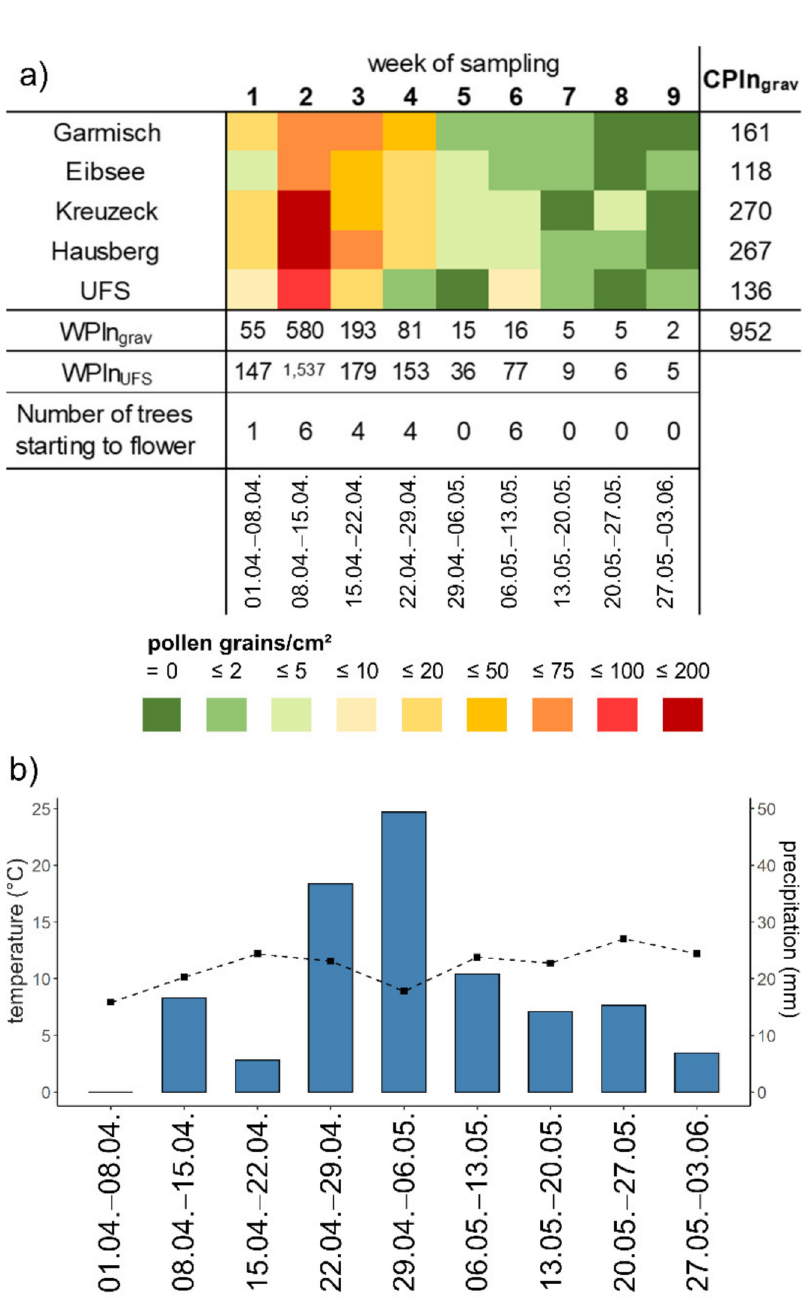
Figure 5. ( a ) Heat map showing weekly birch pollen deposition (pollen grains/cm 2 ) on the horizontal slides during the flowering period 2020, WPIn UFS and the number of birch trees starting to flower in the respective week. ( b ) Weekly mean air temperature (black points) and weekly sum of precipitation (blue bars) recorded at Garmisch-Partenkirchen between 1 April and 3 June